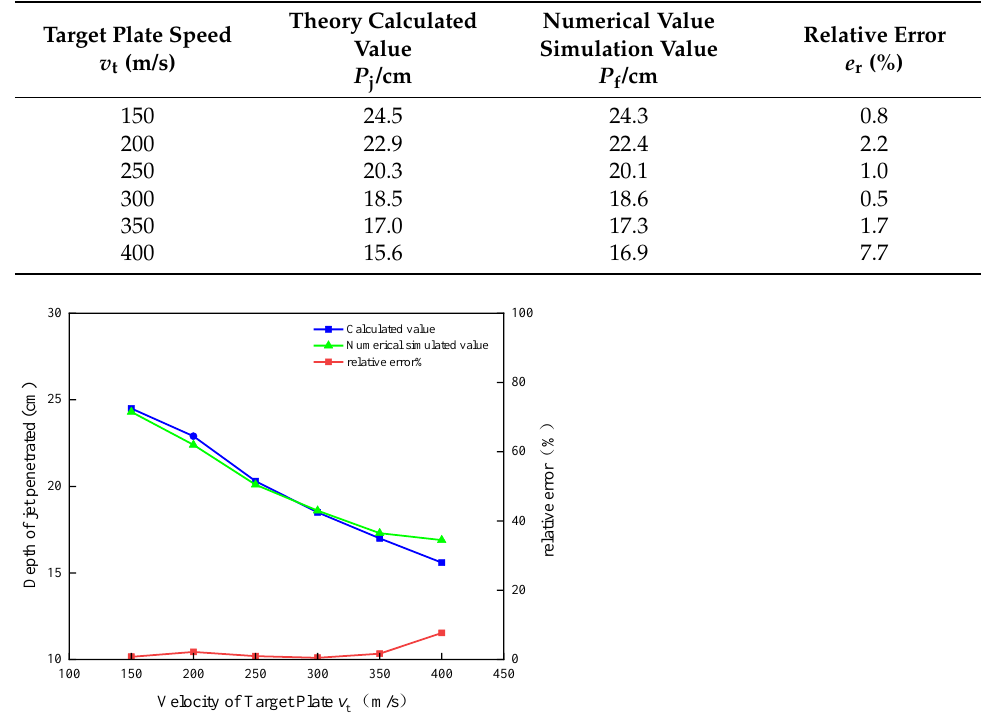
Figure 9. Comparison of jet penetration depth between theoretical calculations and numerical simulations.